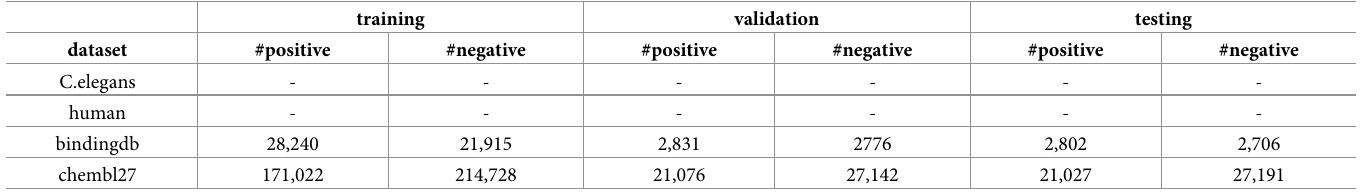
Table 2. Summary of the training and testing data. To small datasets, human and C.elegans , we evaluate the models’ performance using k-fold cross validation, with k = 5. To the other datasets, we split them into three sets: training, validation and